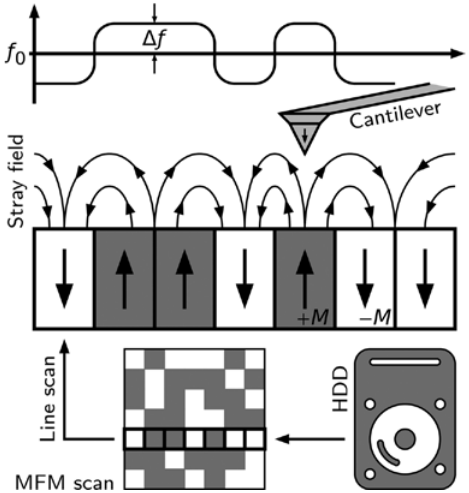
Figure 6: Out-of-plane magnetized storage medium displaying stray field and idealized magnetic force